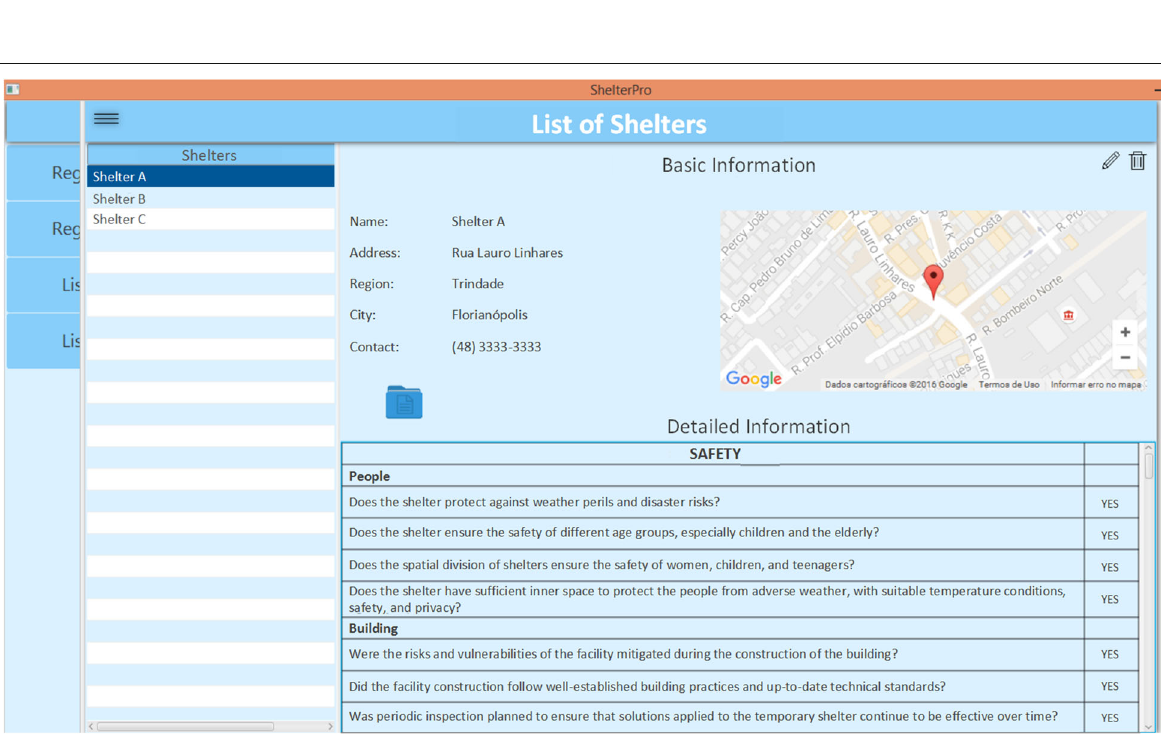
Fig. 10. ShelterPro ranked list of temporary shelters (without an